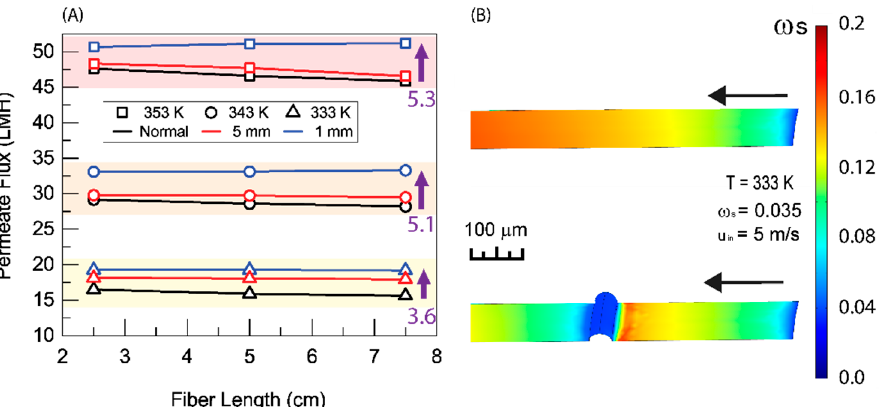
Figure 7. ( A ) Average permeate flux as a function of fiber length with different baffling spacings. ( B ) Salt concentration profile along he membrane surface for a normal (unbaffled) fiber and a fiber with baffling at 1 mm spacing. The result is based on the shell side feed, inner radius 350 µm, thickness 300 µm, R / a 0.35, feed velocity 5 m/s, vacuum pressure 5 kPa, tortuosity 2, pore diameter 400 nm, and porosity 0.5.